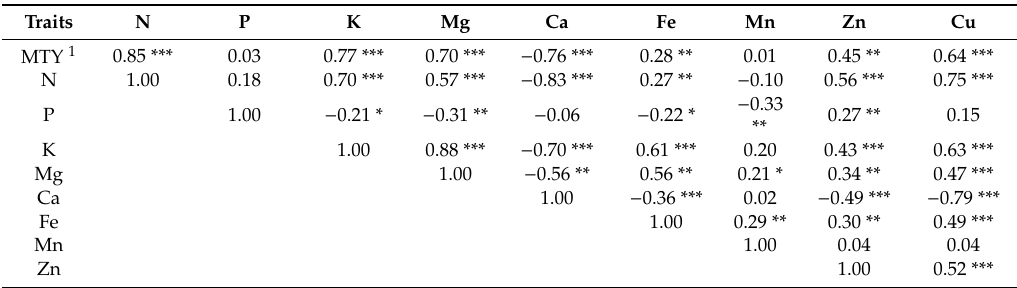
Table A4. Correlation matrix of relationships between nutrients in potato stems and MTY ( n = 96). Traits